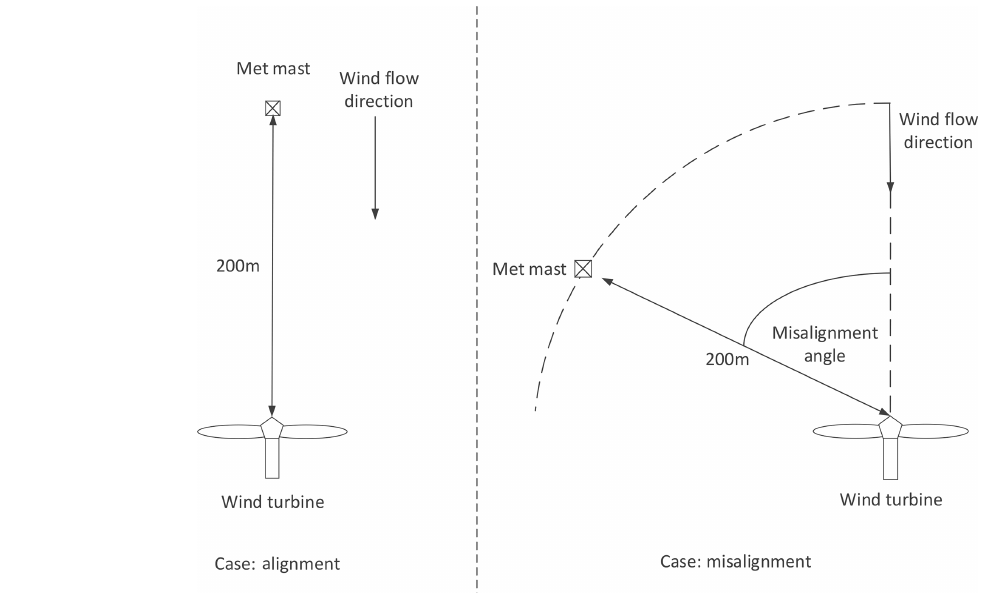
Figure 4. Effect of inflow angle on lateral offset of meteorological mast from wind turbine. Lateral offset is distance orthogonal to direction of wind flow.